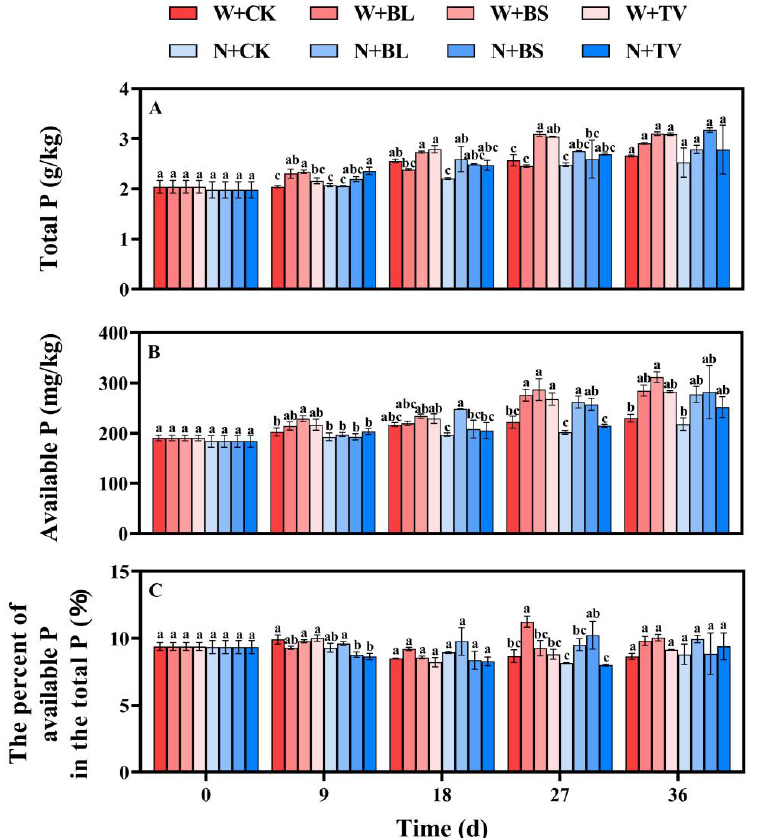
Figure 6. Changes in phosphorus concentrations in the treatments. Means ± SEs with different letters in each parameter indicate significant statistical differences ( p < 0.05). ( A ) Total P; ( B ) Available P; ( C ) The percentage of available P in the total P.